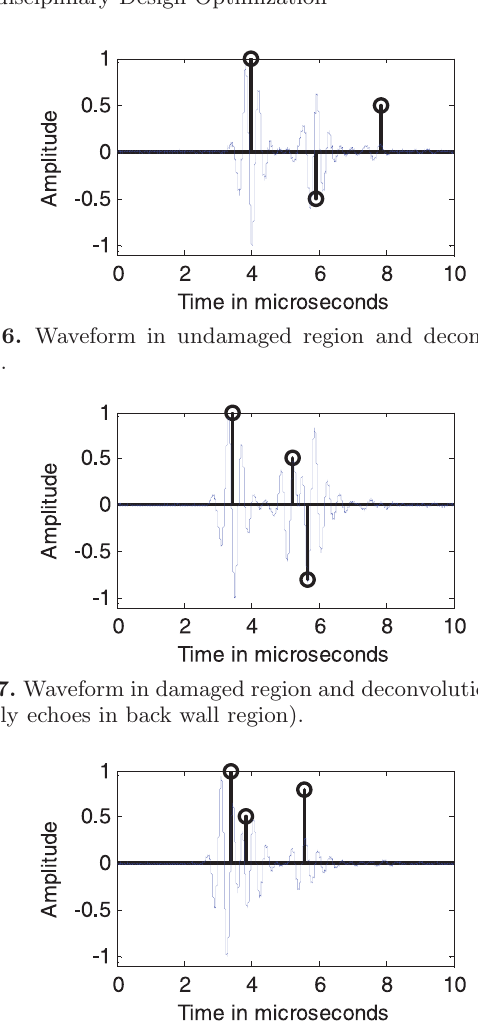
Fig. 8. Waveform in damaged region and deconvolution result (closely echoes in front face